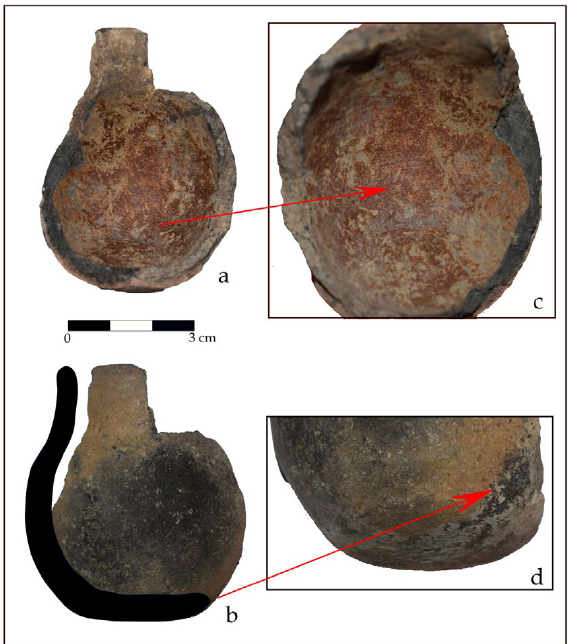
Figure 5. The miniature vessel from Piatra Neamț — Bâtca Doamnei : ( a ) interior of the vessel; ( b ) exterior of the vessel; ( c ) interior detail; ( d ) exterior detail